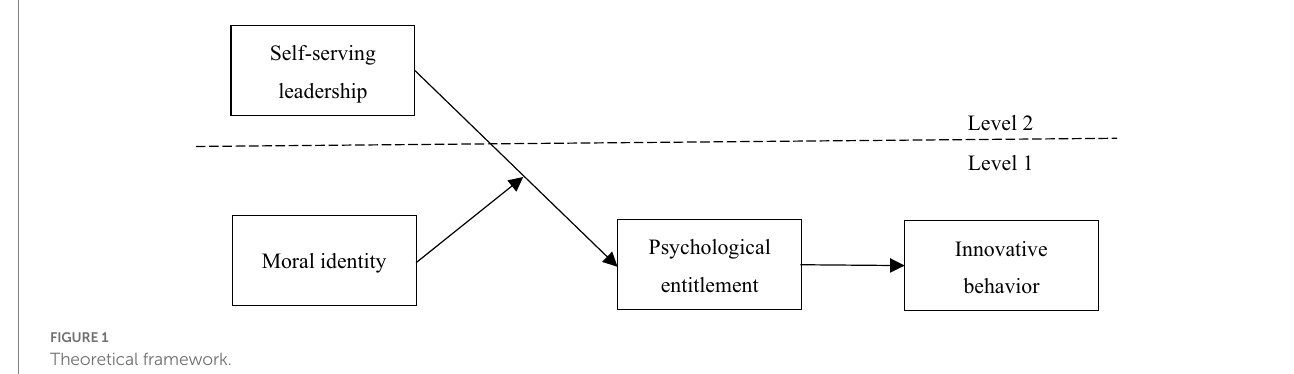
FIGURE 1 Theoretical